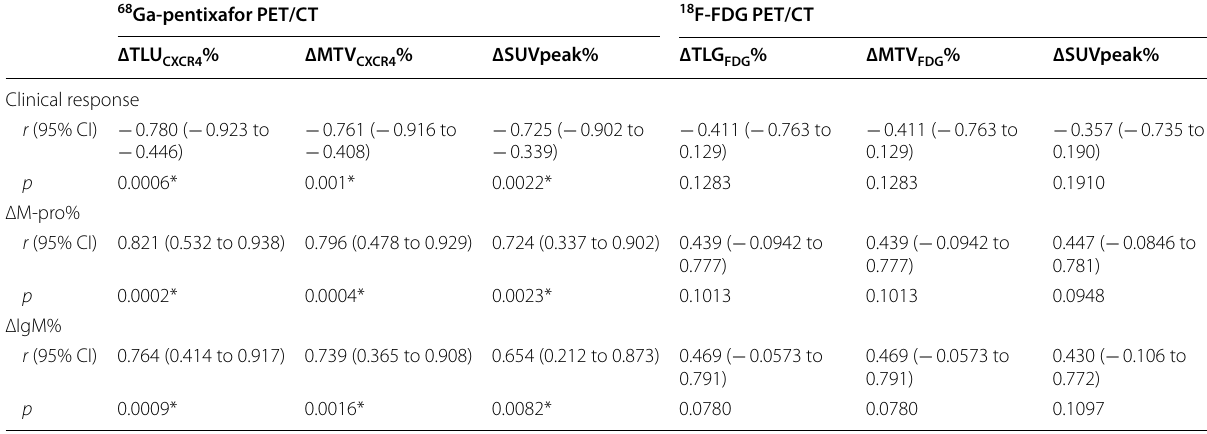
Table 2 Spearman’s rank correlation test of semi-quantitative PET/CT-based response and clinical